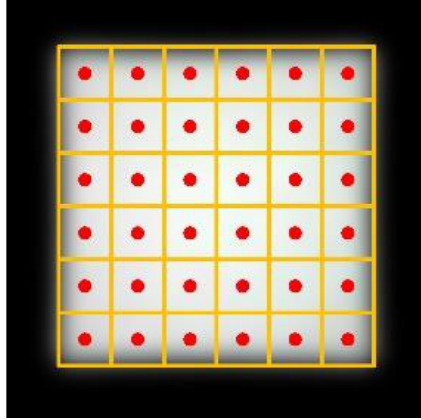
Figure 8. Distribution of sampling points.